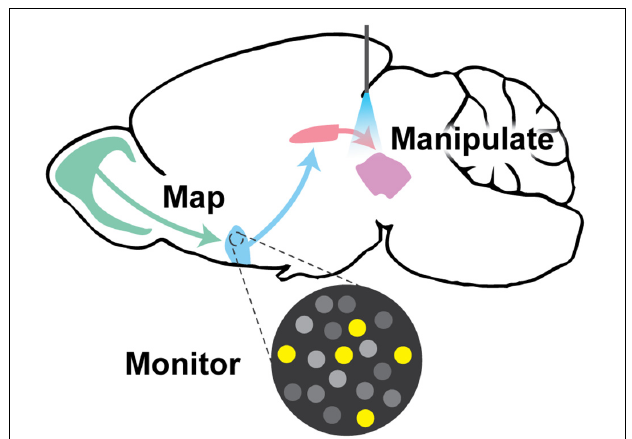
FIGURE 1 | Visual abstract. This review discusses the paramount goals in neural circuitry research, which are to (1) map neural circuit connectivity using viral tracing approaches, (2) monitor circuit function using methods such as electrophysiology and genetically encoded indicator/voltage/sensor imaging, and (3) manipulate neural circuits to interrogate function via targeted ablation, expression of exogenous ion channels, chemogenetics, or optogenetics. All of these approaches require creative genetic tools to implement them in genetically-defined populations of